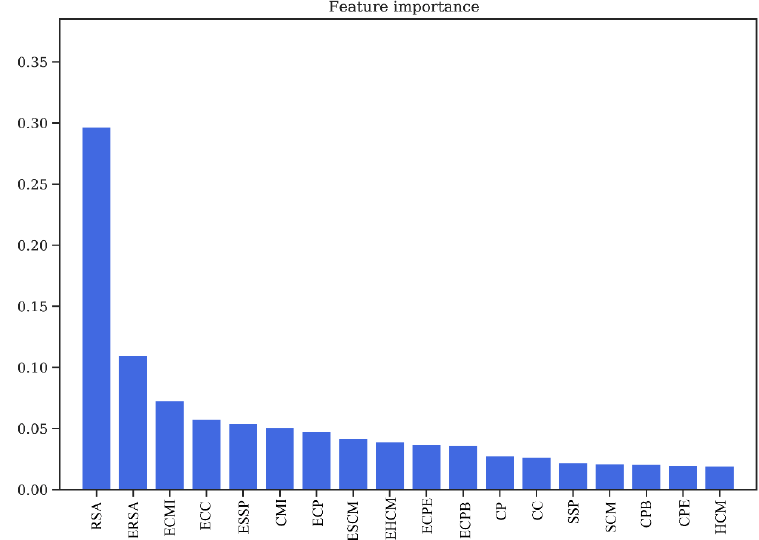
Figure 4. Feature importance obtained from Random Forest classifier / relative solvent accessibility